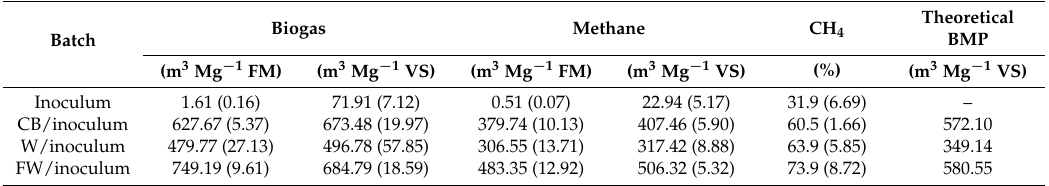
Table 5. Cumulative biogas and methane